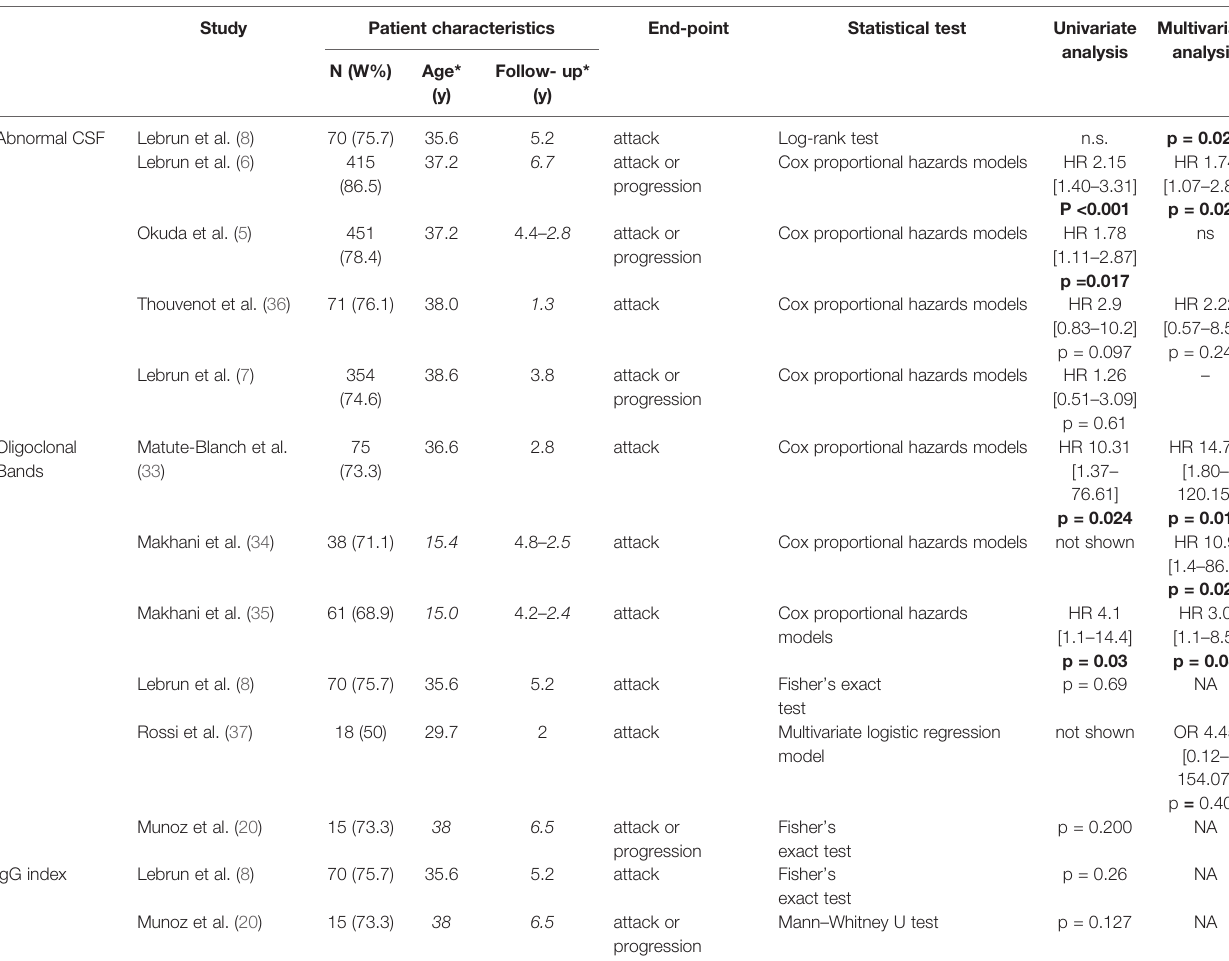
TABLE 1 | Prognostic value of oligoclonal bands and/or IgG index in cerebrospinal fl uid in patients with radiologically isolated syndrome.